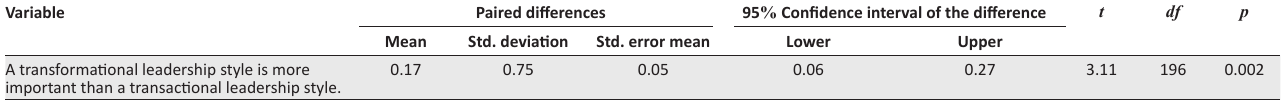
TABLE 2: Results of the paired samples t -test for differences in mean scores of transformational leadership and transactional leadership. Variable Paired differences 95 % Confidence interval of the difference